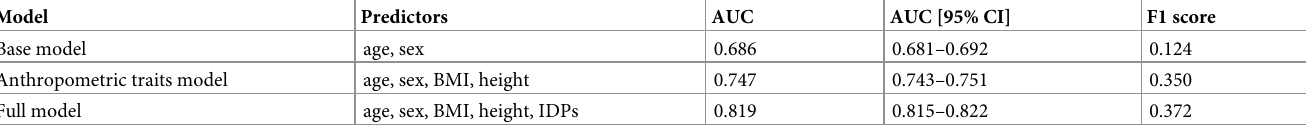
AUC: Area under the